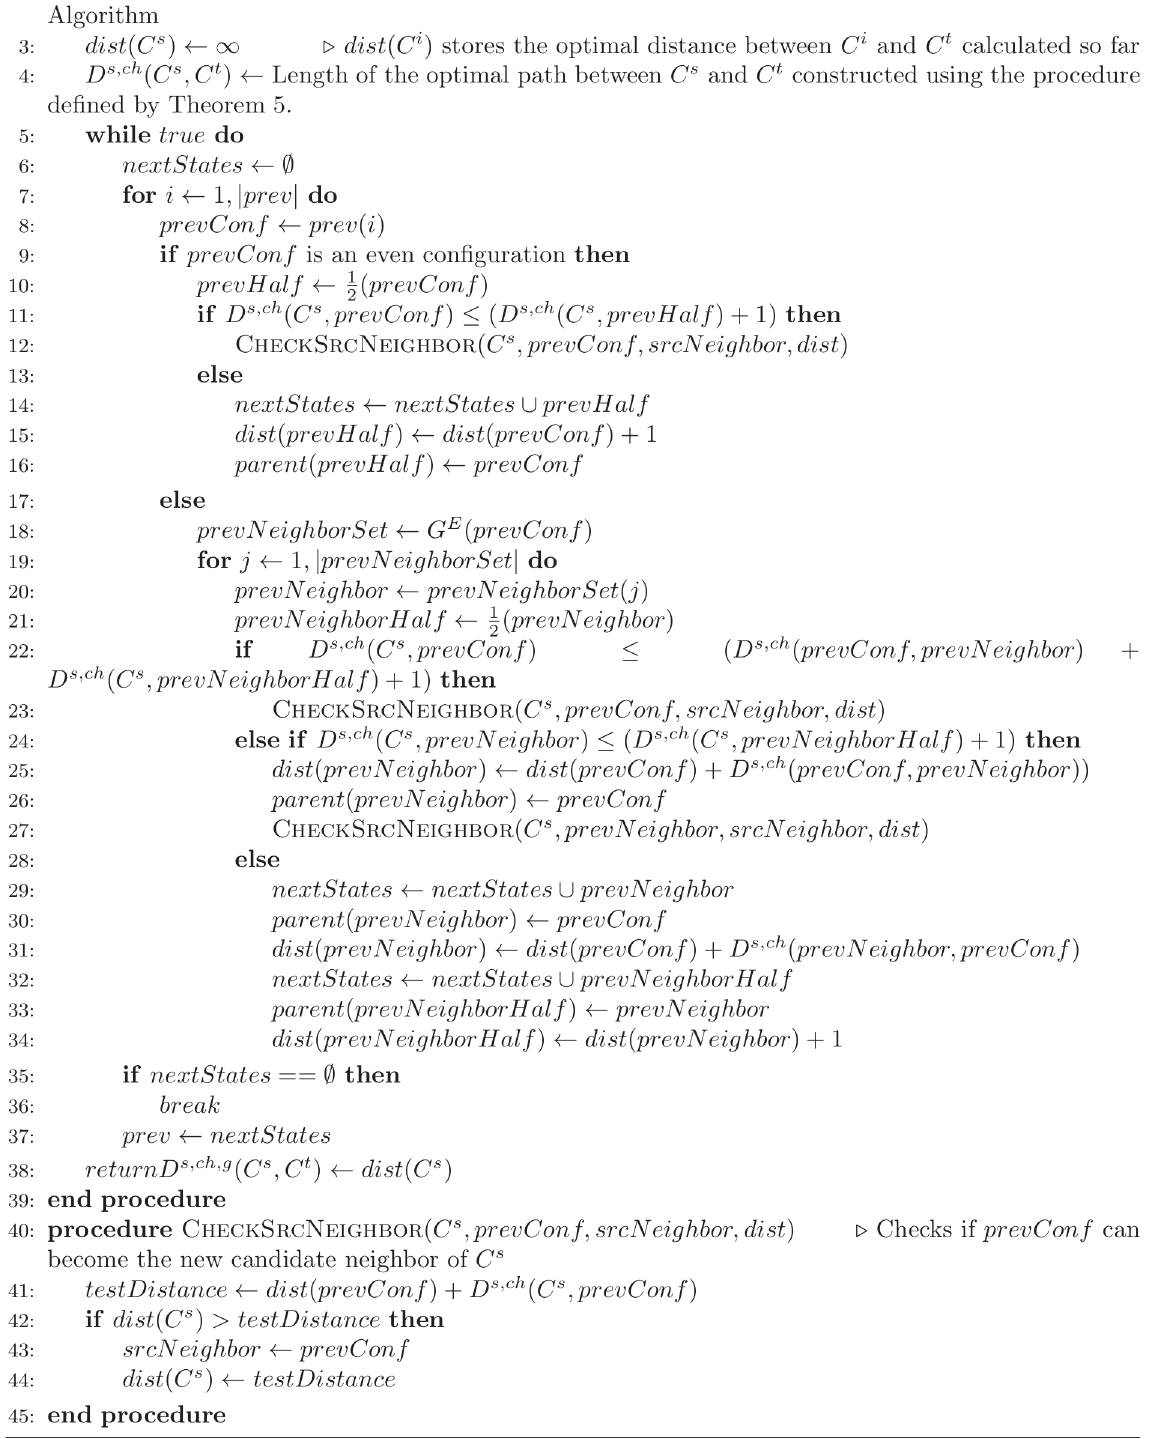
Figure 11. Algorithm 2 pseudocode. Algorithm 2 finds the shortest directed distance between two configurations using SD, CD, and GD events.